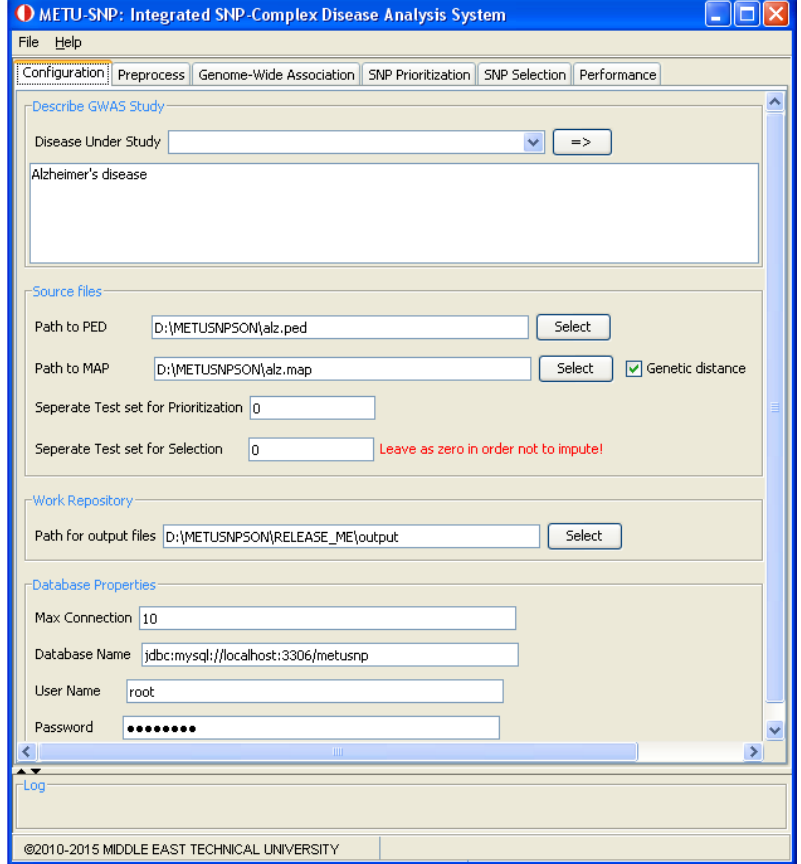
Figure 1: METU-SNP